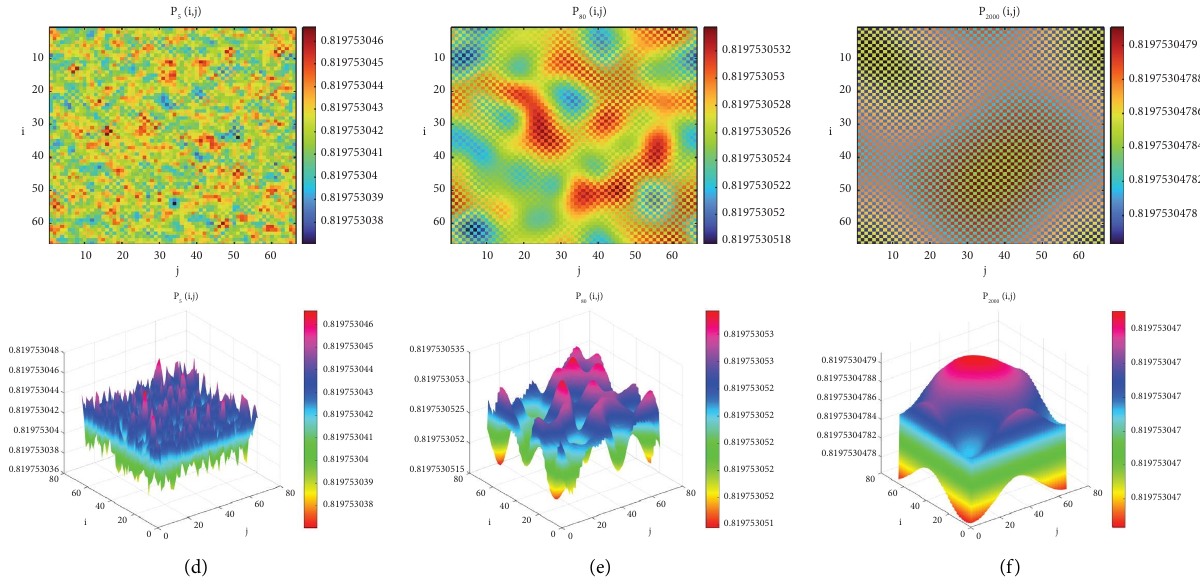
Figure 22: R � 2 ,k � 1, c � 0 . 8, σ ∗ � 0 . 278655, σ � σ ∗ , ( d which is consistent with the case of Corollary 3(7), a Neimark-Sacker-Flip bifurcation occurs, the number of parasites and hosts in two- dimensional space can show periodic doubling and periodic oscillation alternately.